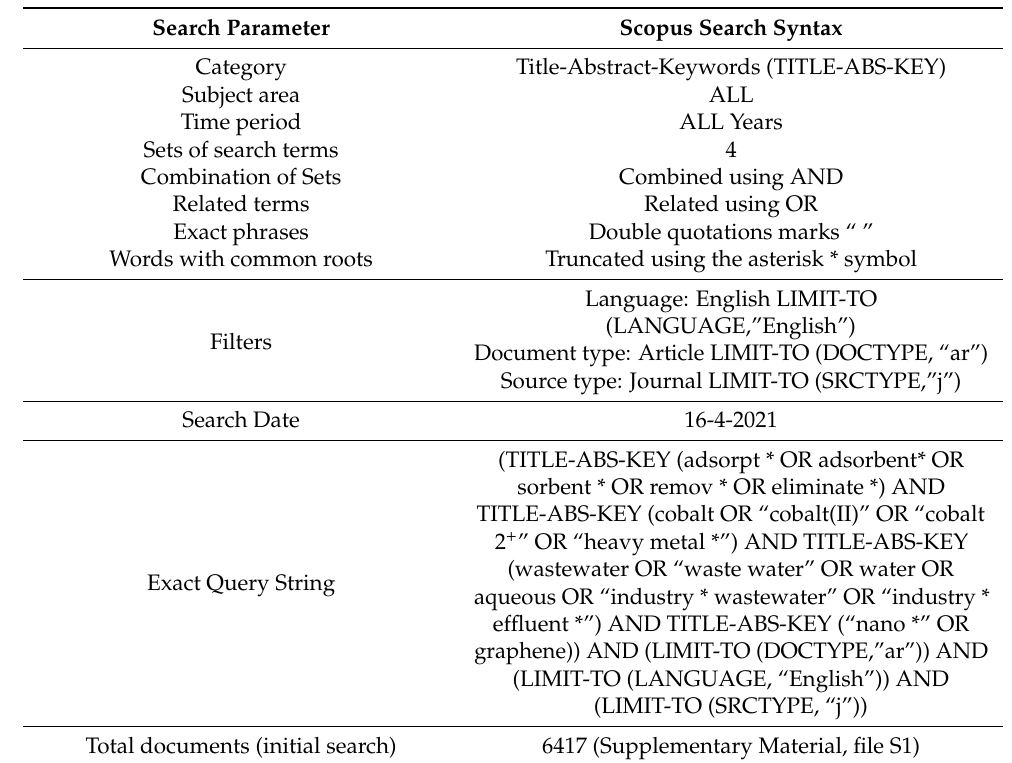
Table 1. Search approach on Scopus